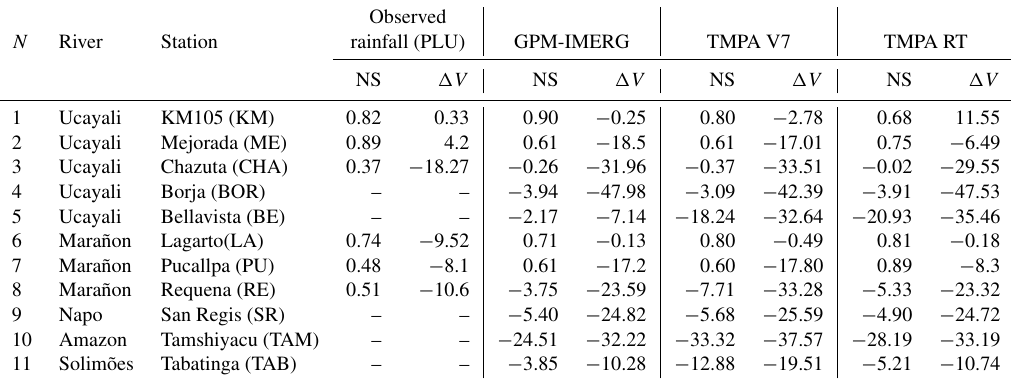
Table 5. Summary of modeling results at 11 gauging stations in the Amazon Basin of Peru and Ecuador (to Tabatinga station in